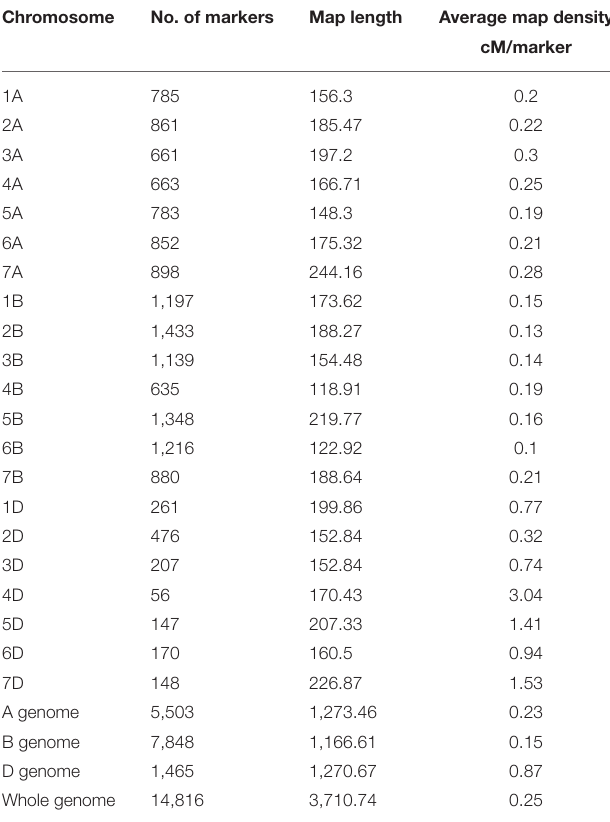
TABLE 3 | Chromosome and genome wide distribution of markers in our spring wheat association mapping panel based on the 90k SNP consensus map (Wang et al.,